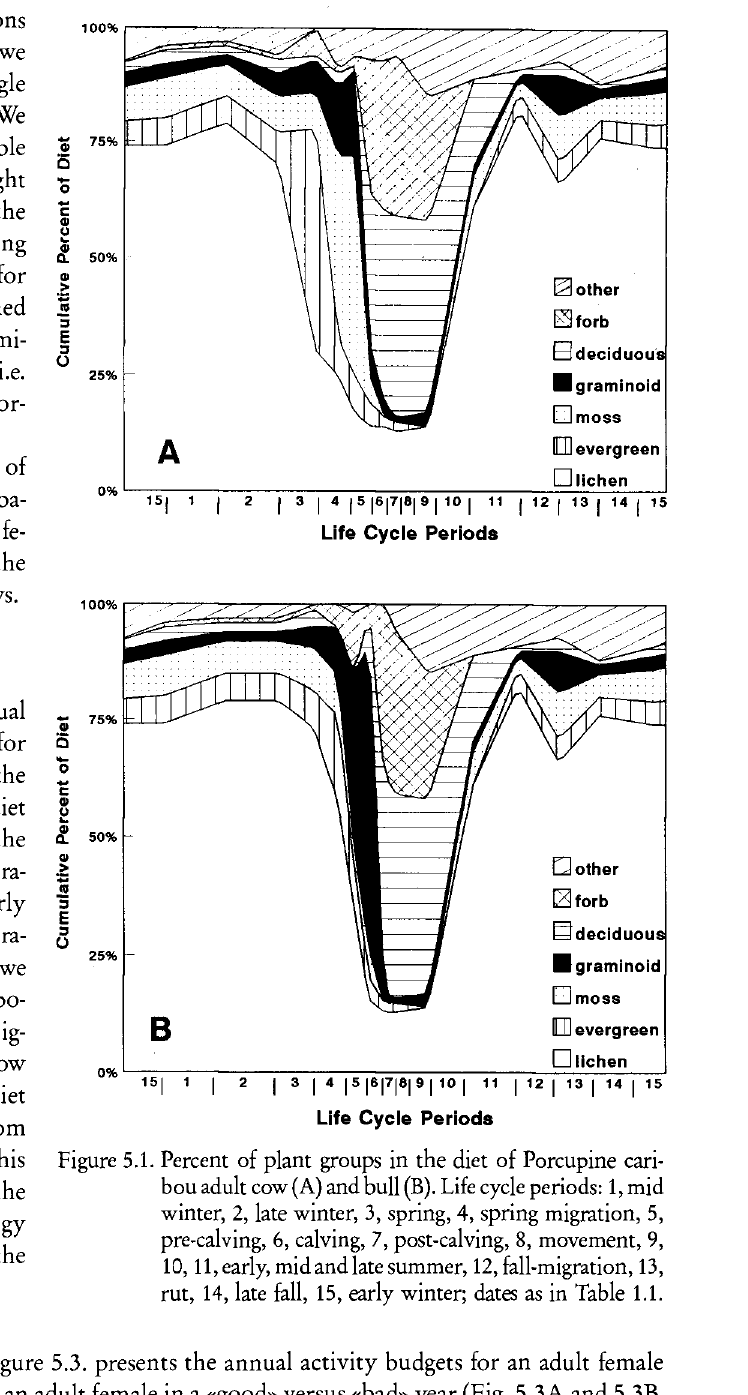
Figure 5.1. Percent of plant groups in the diet of Porcupine cari bou adult cow (A) and bull (B). Life cycle periods: 1, mid winter, 2, late winter, 3, spring, 4, spring migration, 5, pre-calving, 6, calving, 7, post-calving, 8, movement, 9, 10,11, early, mid and late summer, 12, fall-migration, 13, rut, 14, late fall, 15, early winter; dates as in Table